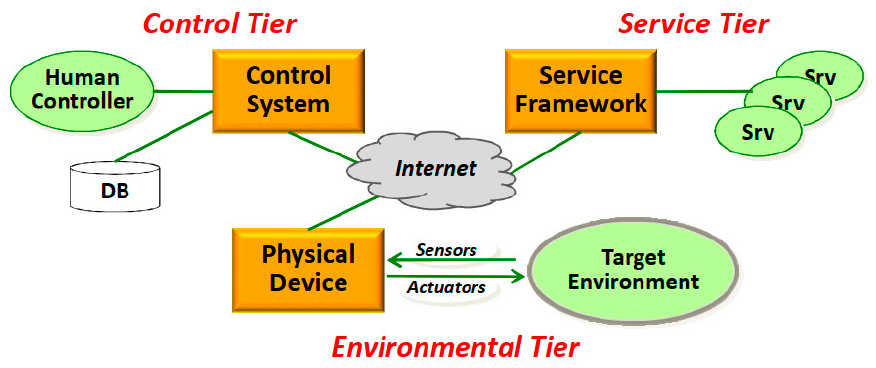
Figure 3. 3-Tiers IoT framework [20].